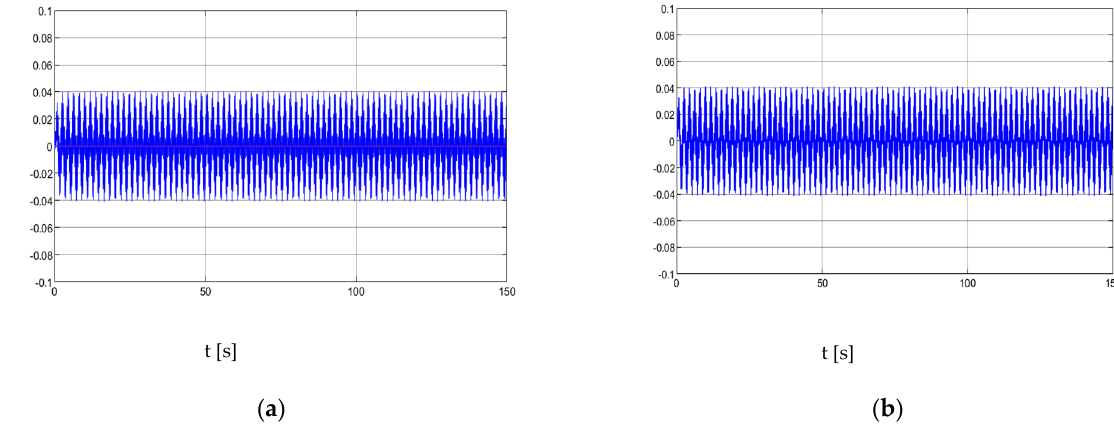
Figure 4. The system response in the case of active force 𝐹 𝐴1 action on the inertial elements (I method of reduction): ( a ) 𝑚 4 ; ( b ) 𝑚 1 .